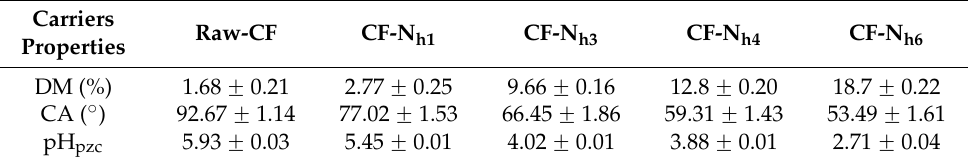
Table 2. The properties in raw and treated CF carriers.